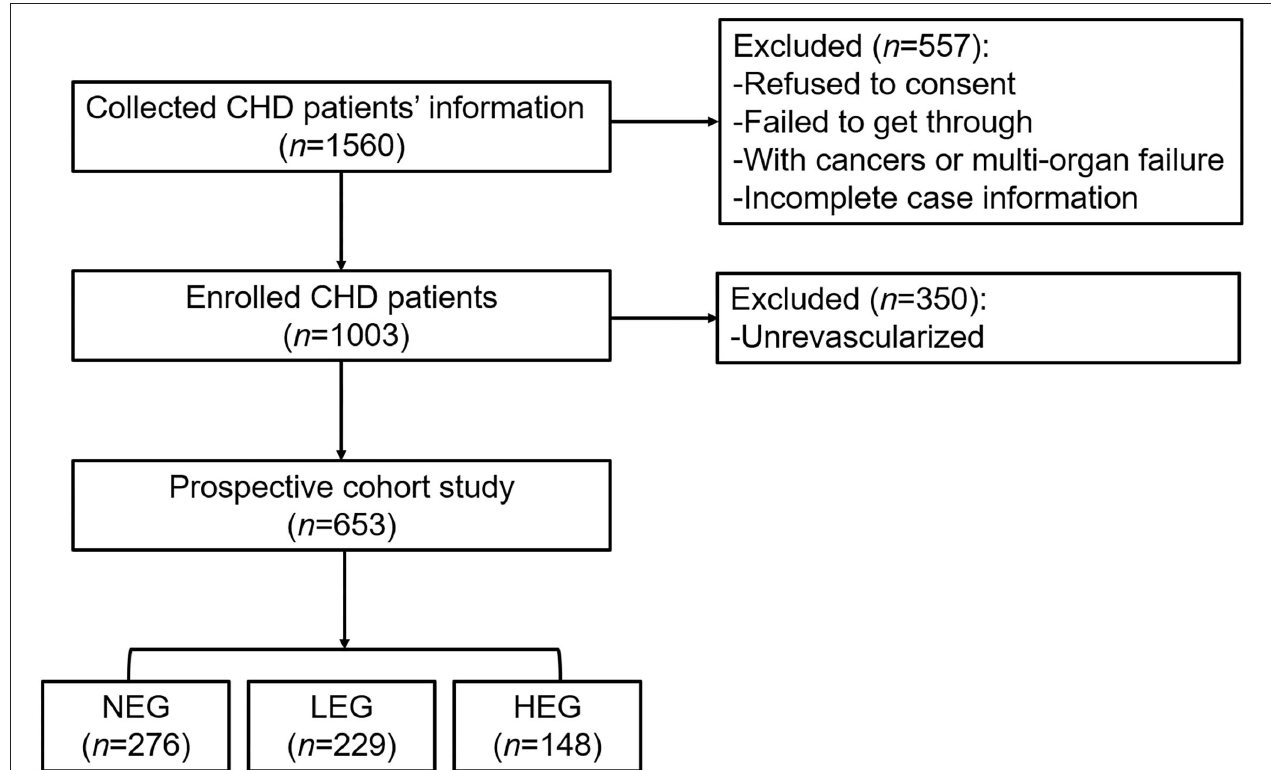
FIGURE 1 | The flowchart of the study. TCM, Traditional Chinese Medicine; NEG, non-exposure group; LEG, low-exposure group; HEG, high-exposure